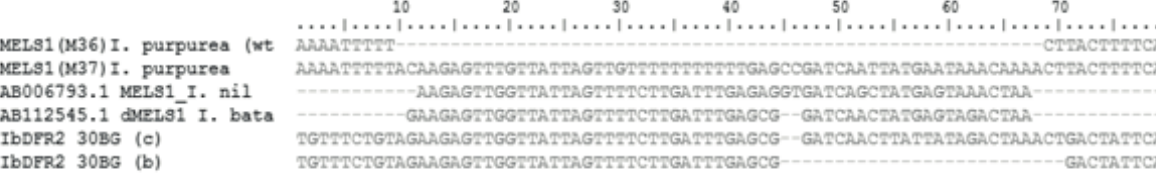
Figure 2. Sequence alignment of two bands corresponding to intron two and 3´ exon three of the DFR-B genes amplifi ed in I. batatas (Ib DFR2) to the region of the transposable elements described in I. nil (AB006793.1: 9709- 9764) and I. purpurea . The sequence of dMELS1 shows some base substitutions. Band (b) presented the same dMELS1 and an additional deletion (33 pb). Band (c) also presented dMELS1 with some base